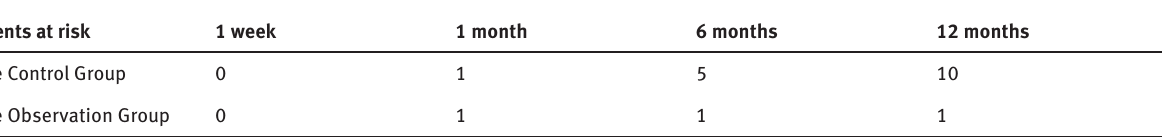
Table 6: Kaplan-Meier survival analysis for ticagrelor ( red ) vs clopidogrel ( black ) for 1 year of follow- up